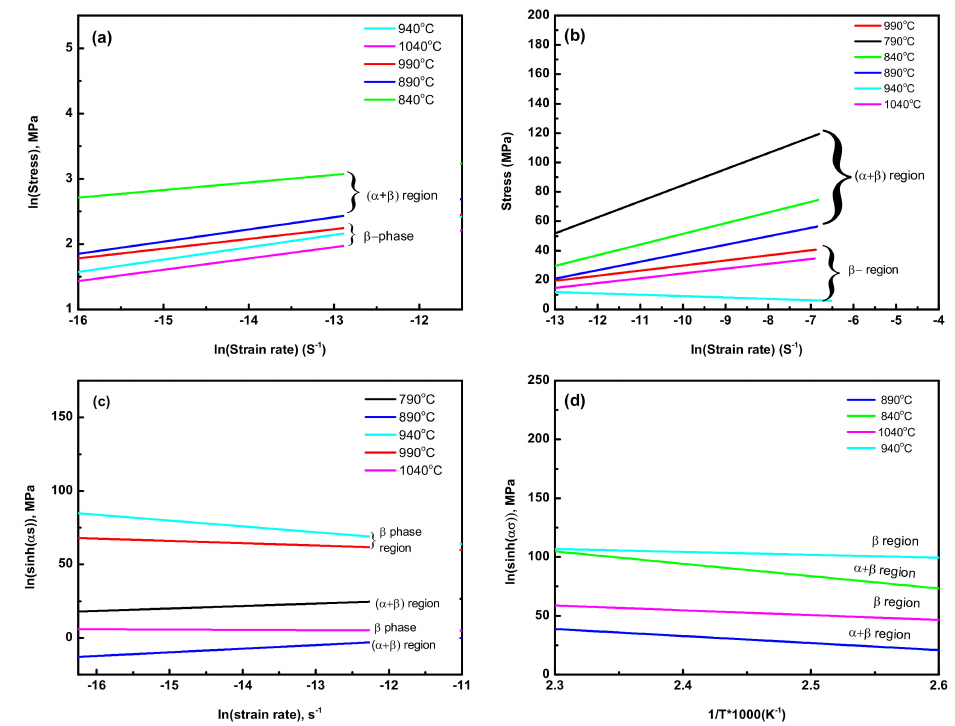
Figure 4. Typical functional relationship plot between ln( ε ) and ln( σ ) to determine the material constant, n 1 , at a strain rate of 0.01 s − 1 ( a ), the functional relationship between ln( ε ) and σ to determine the material constant, β , at a strain rate of 0.1 s − 1 ( b ), the relationship plot between ln(sinh( ασ )) and ln( ε ) to calculate n at a strain rate of 0.001 s − 1 ( c ), and variation of flow stress with the inverse of change in temperature to calculate the activation energy, Q, of as-cast Ti6Al4V-5Cu alloy severely deformed by hot compression at 0.01 s − 1 ( d